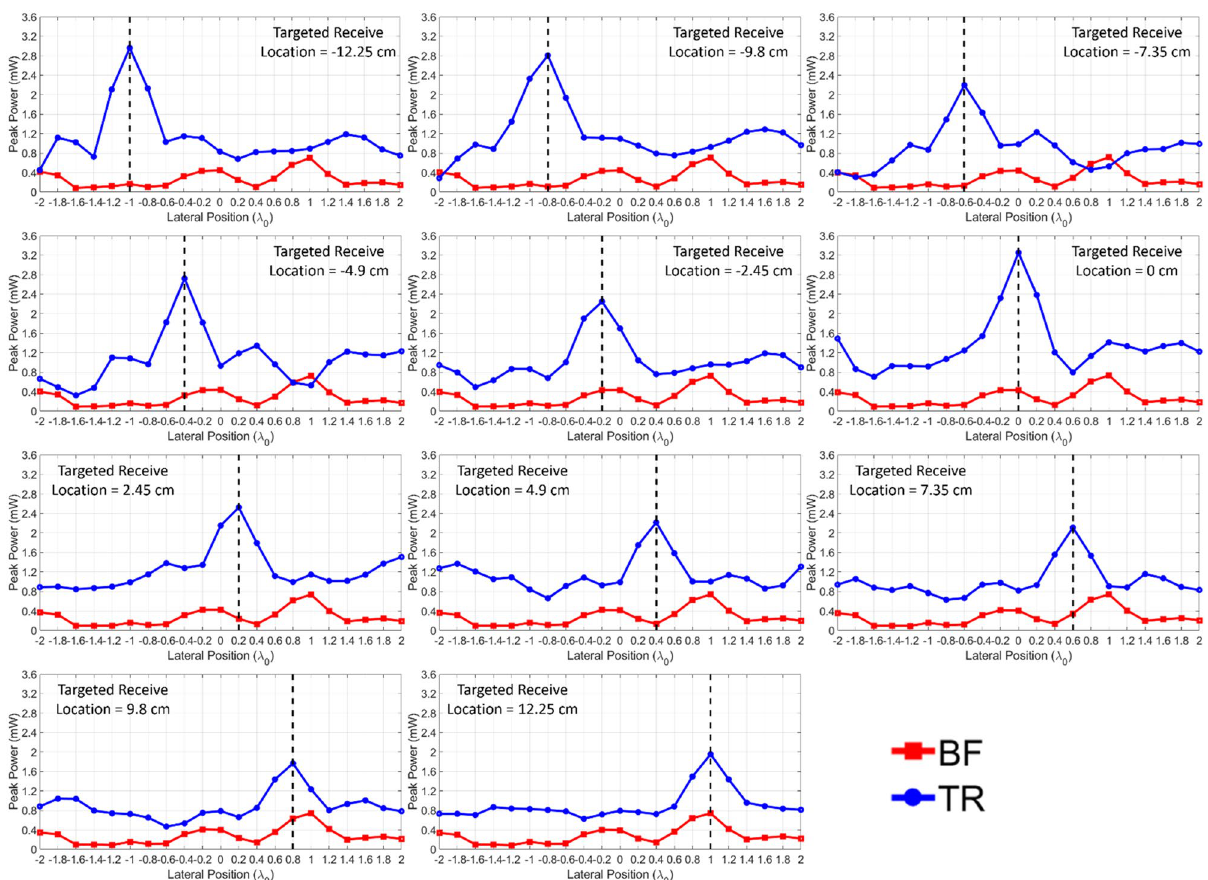
Figure 6. Measured peak power at the receiver as a function of lateral position resulting from BF and TR in an indoor environment.